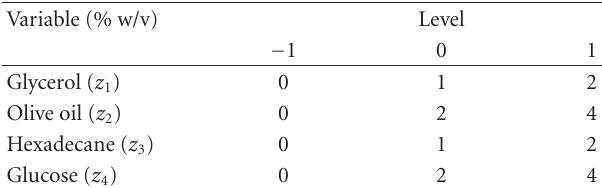
Table 2: Experimental range and levels of the independent variables used in the 2 4 full factorial design for the carbon source